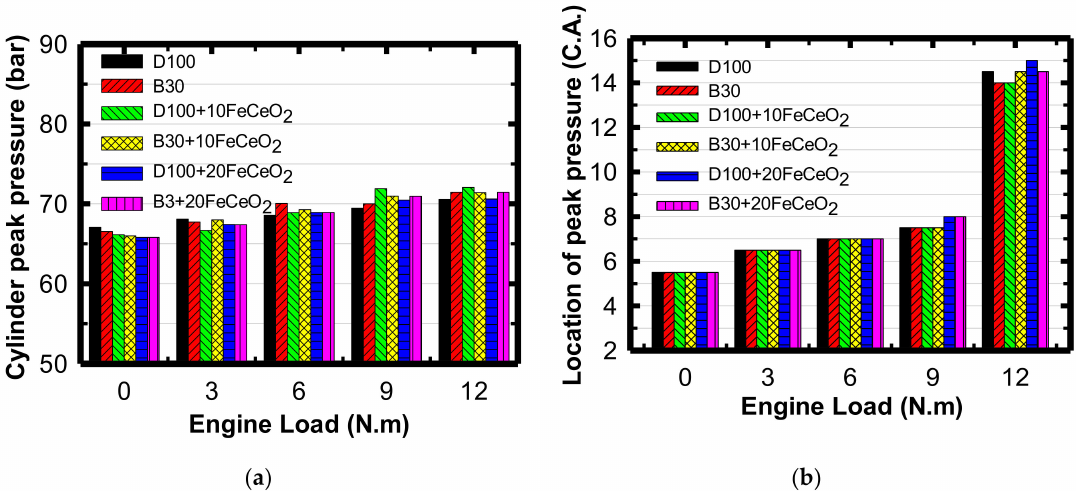
Figure 6. The peak cylinder pressure and its location at different engine loads for engine speed of 2000